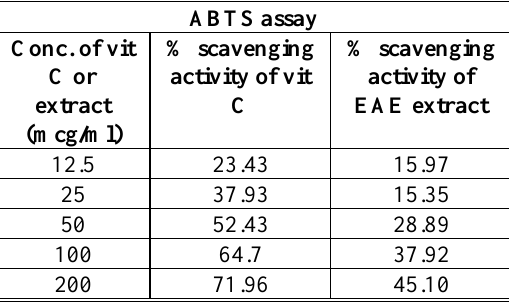
Table 3.The ABTS-radical scavenging activity of C.grandiflora EAE.